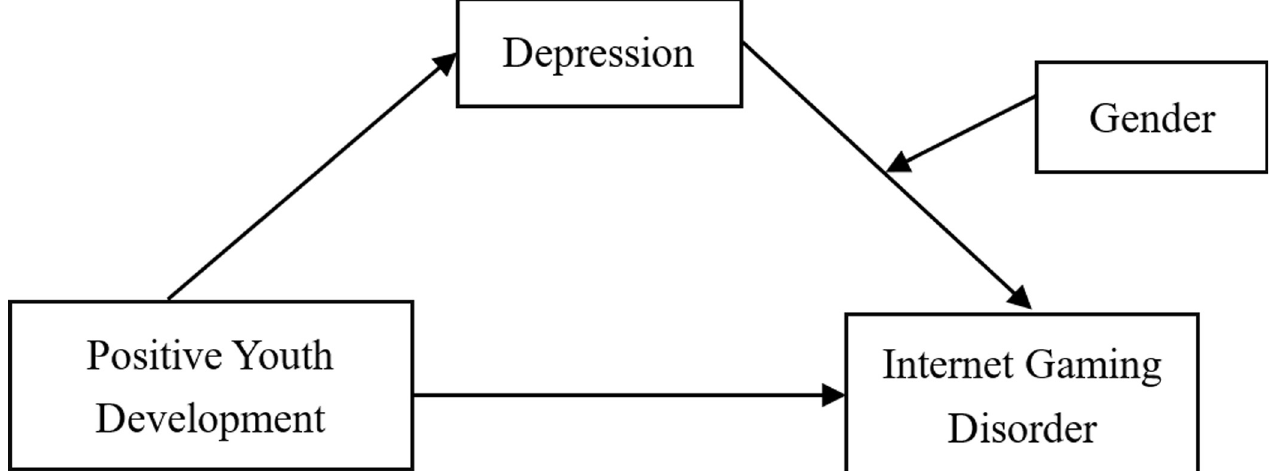
Fig 1. A moderated mediation model of positive youth development, depression, internet gaming disorder and gender.